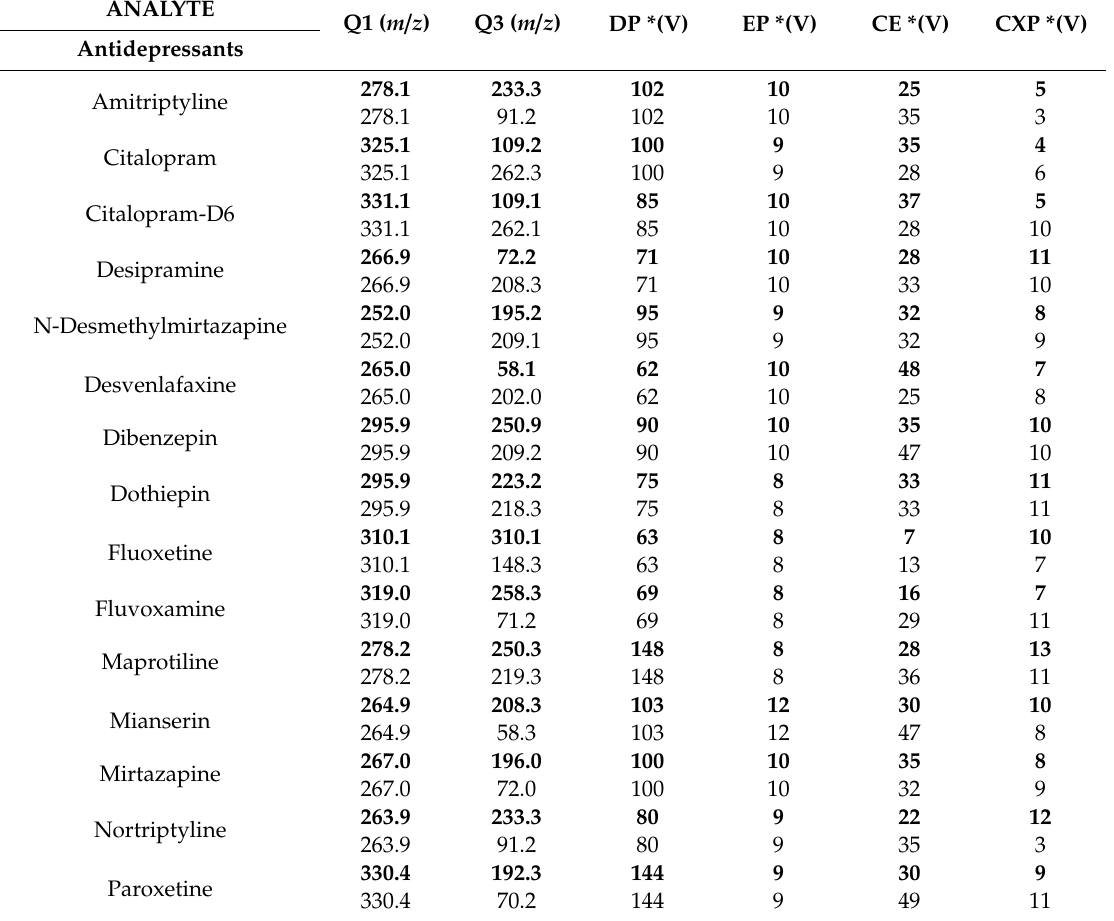
Table 7. Multiple reaction monitoring (MRM) transitions for each substance. Quantifier transitions in